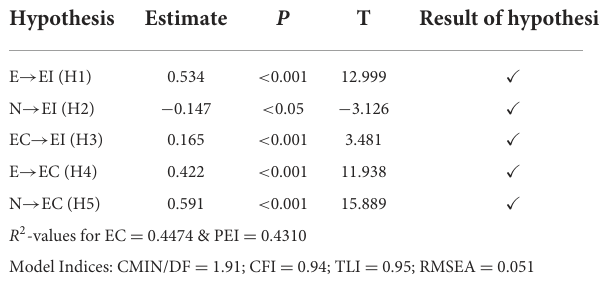
TABLE 3 Results of path